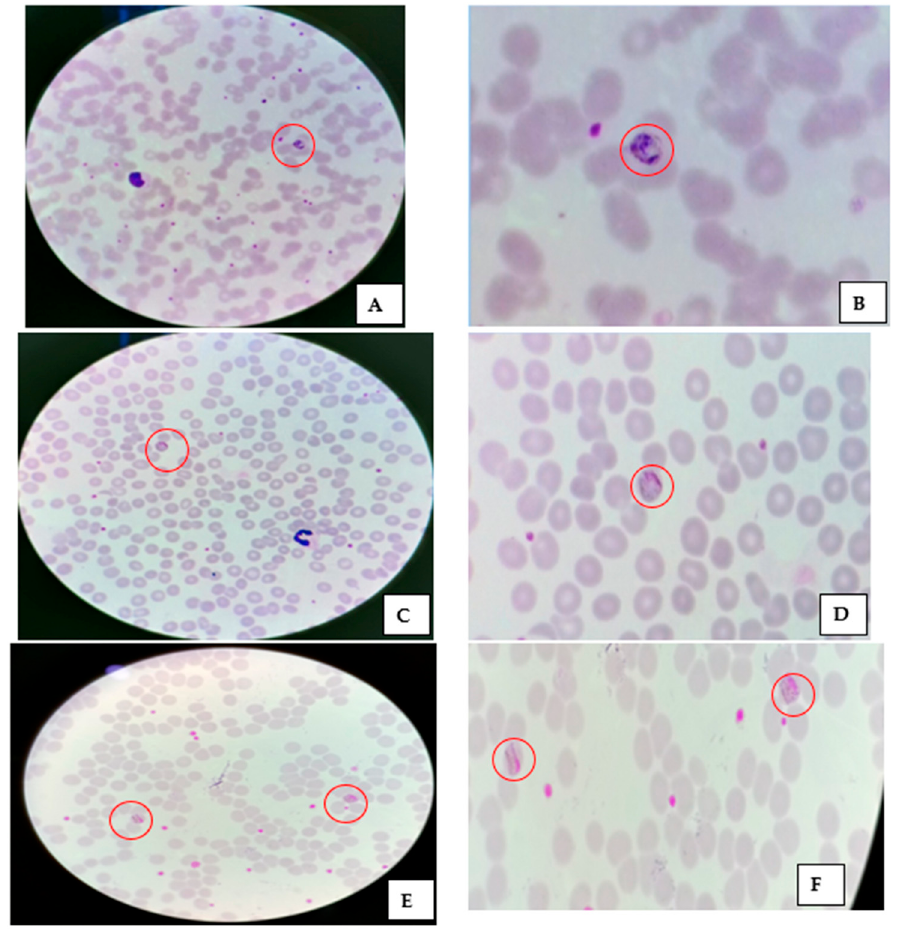
Figure 4. Thin smear and its magnified images showing ( A , B ) a developing schizont; ( C , D ) a gametocyte; ( E , F ) the band form of trophozoites. Table 1. Age group- and gender-wise malaria cases diagnosis using RDTs and microscopy.